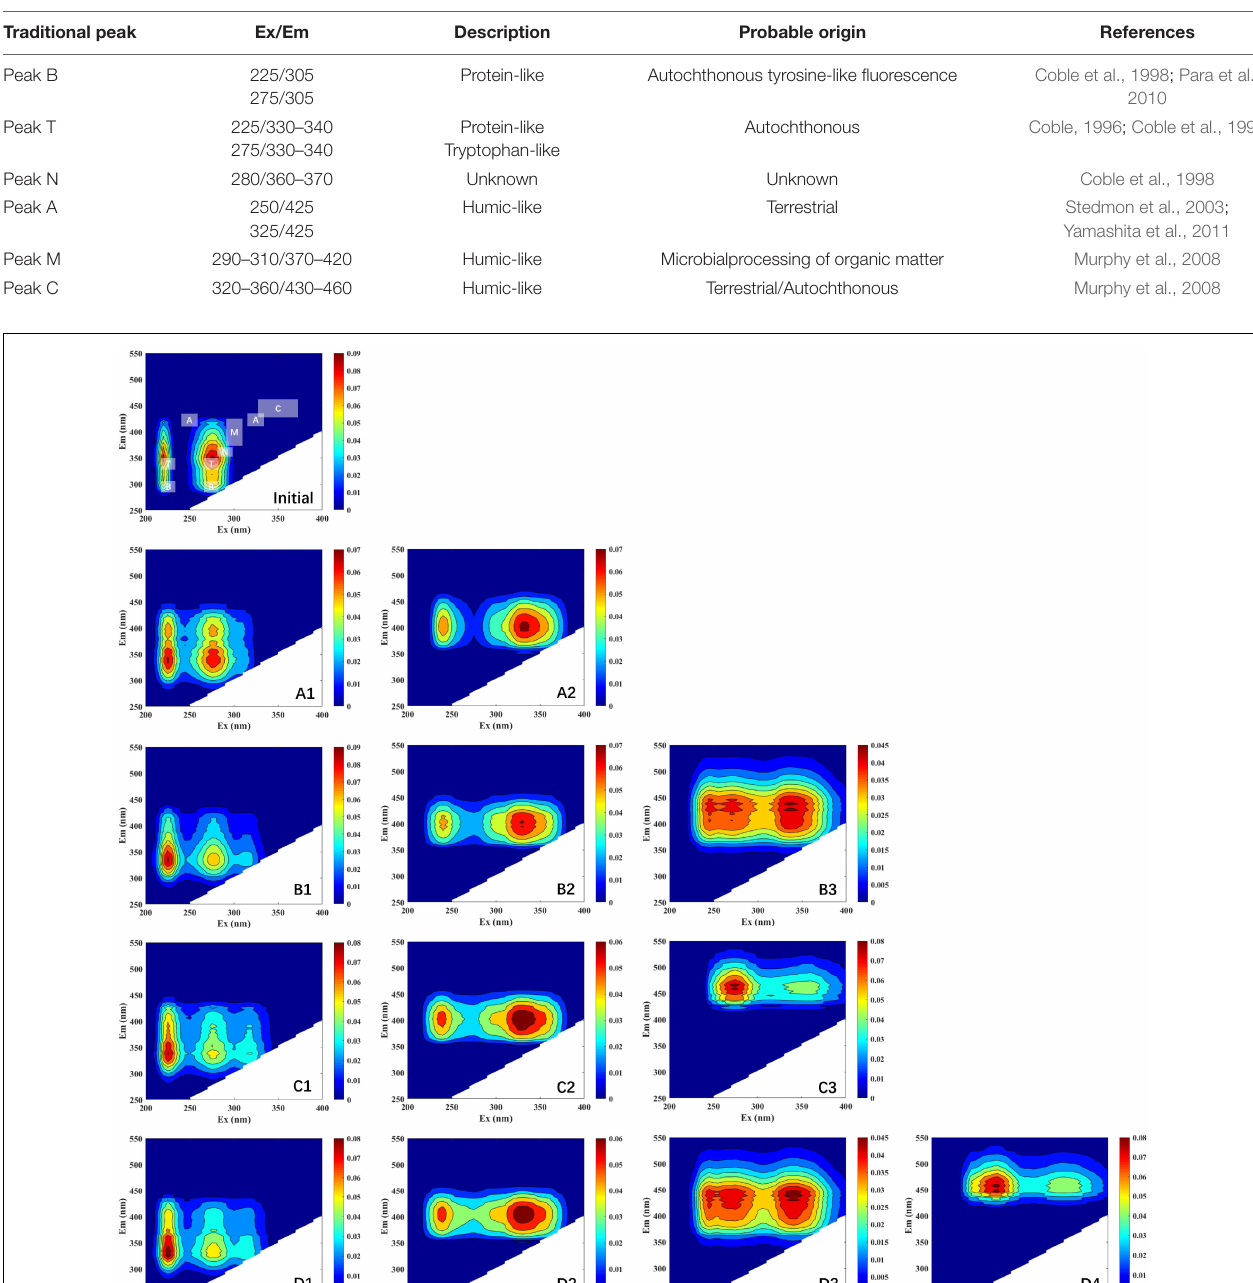
TABLE 2 | EEM fluorescence spectral features attributed to various organic matter sources.